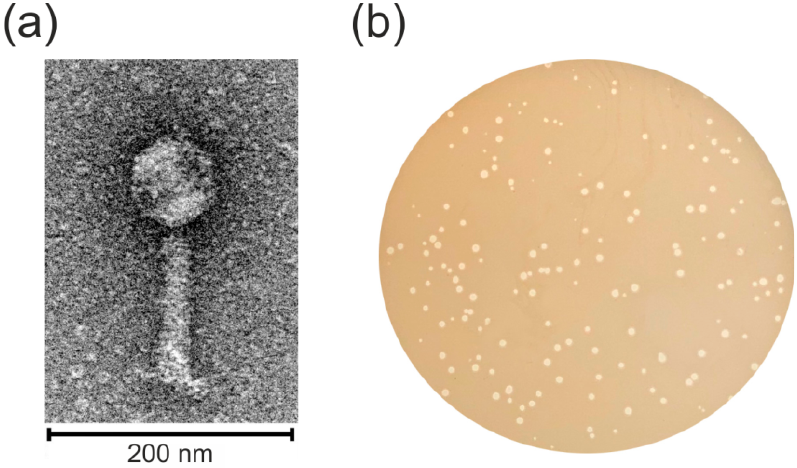
Figure 1. Characteristics of the virion ( a ) and plaques ( b ) of the vB_SspM_BZS1. The scale bar in the transmission electron microscopy (TEM) image represents 200 nm.